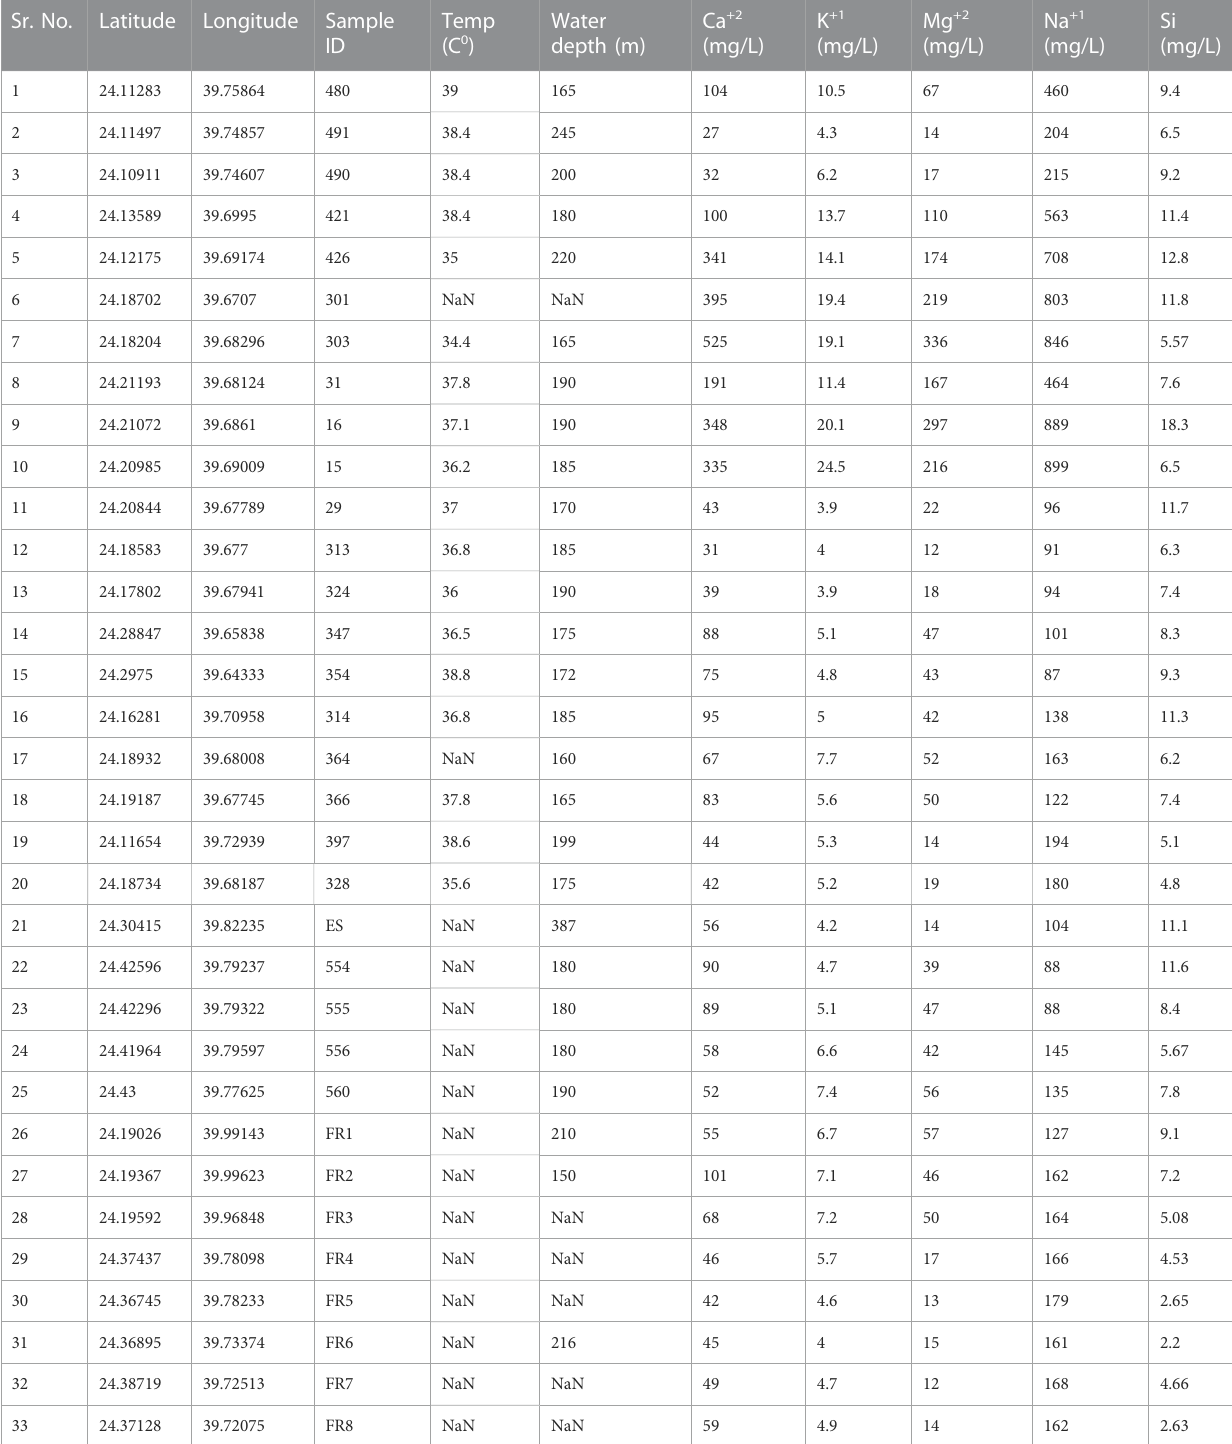
TABLE 4 Details of water samples has been utilized for major elements (Ca +2 , K +1 , Mg +2 , Na +1 , Si). Sr.